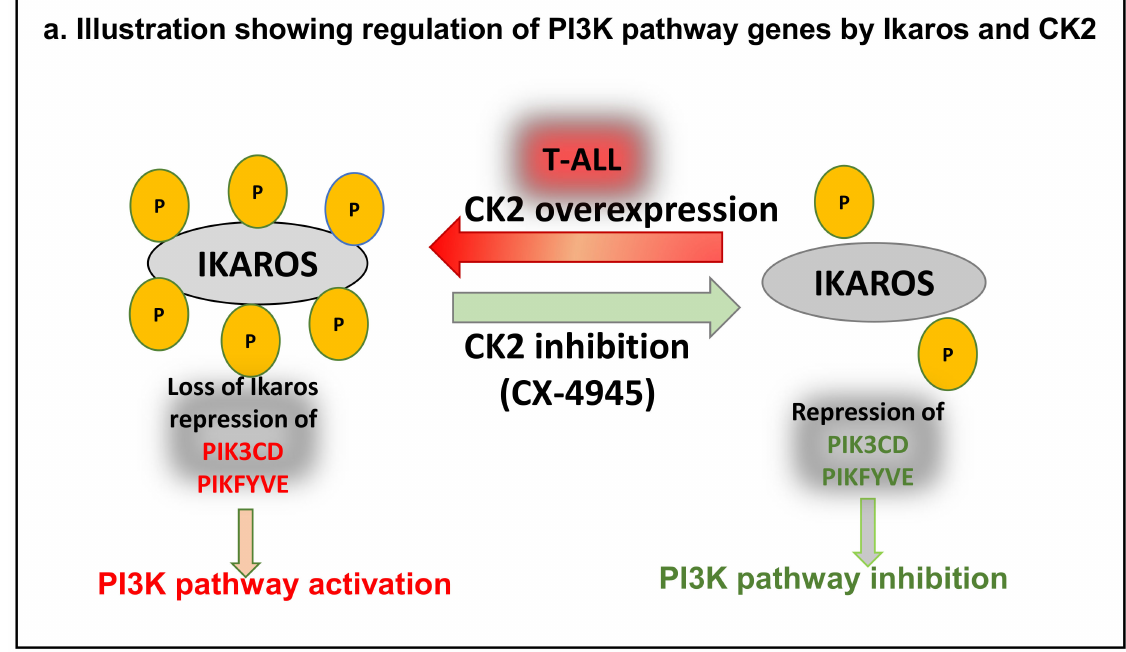
Figure 6. Model illustration of regulation of PI3K pathway genes PIK3CD and PIKFYVE in T-ALL by CK2 and